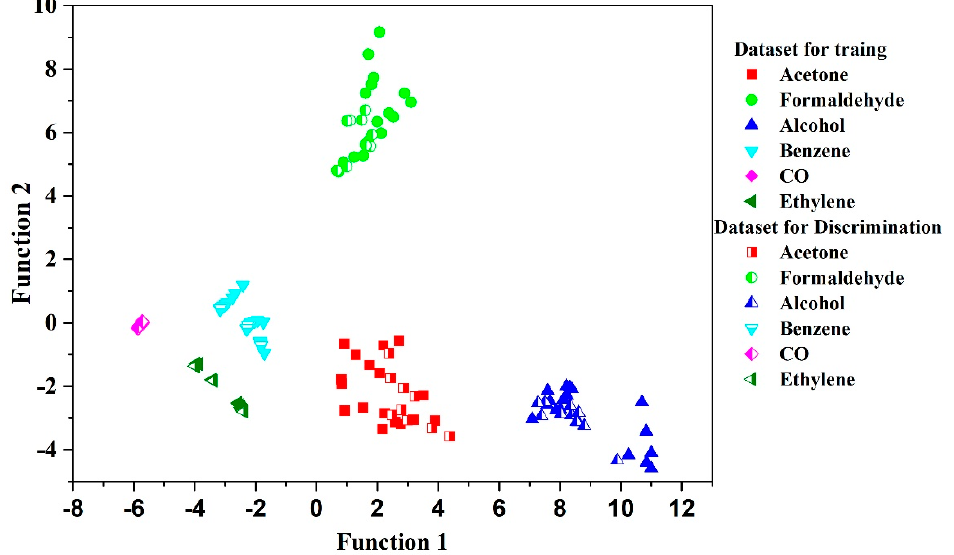
Figure 10. The Fisher discriminant analysis (FDA) results of all samples. Table 3. The classification rates of FDA (Groups 1–6 represent CO, ethylene, benzene, ethanol, acetone and formaldehyde, respectively).